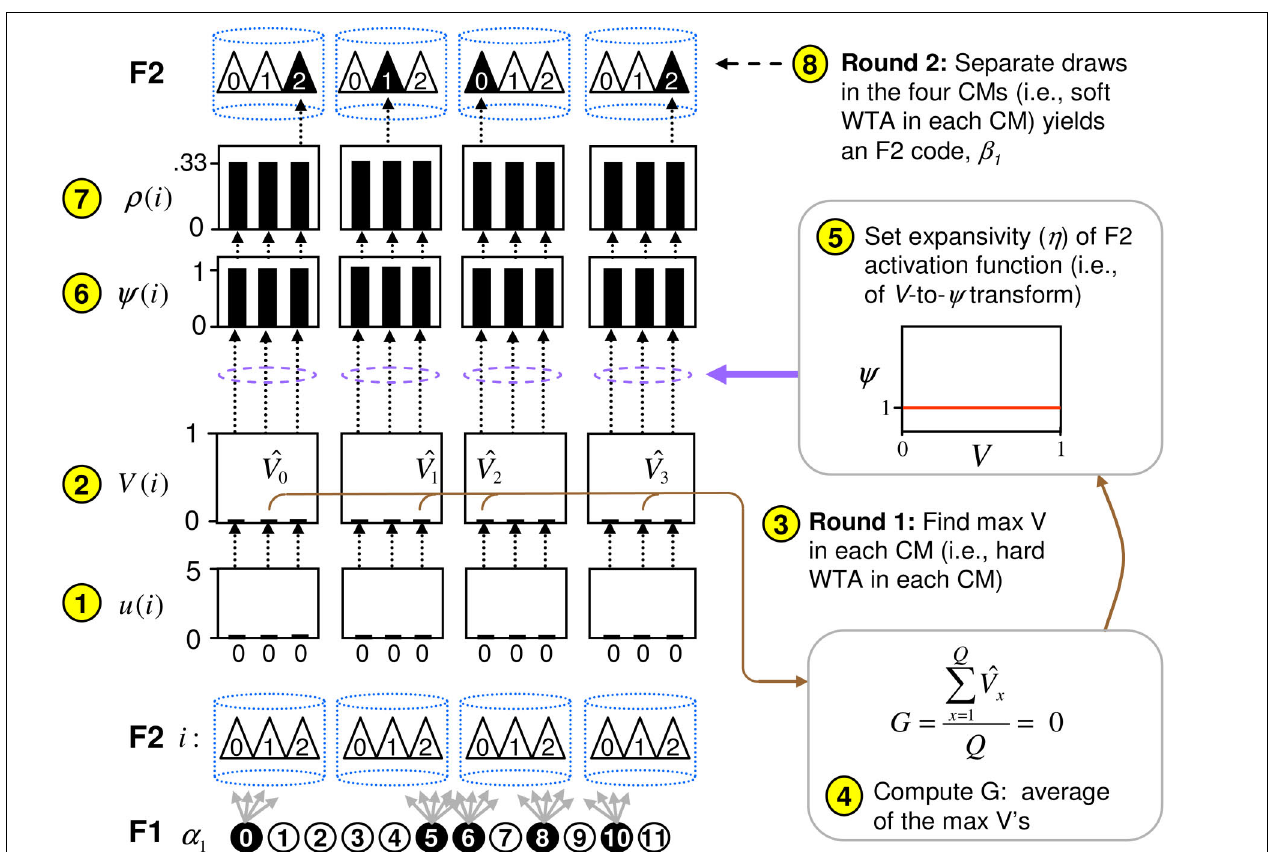
to be 0, and sets the F2 activation function to a constant function (red line), FIGURE 3 | Graphic illustration of the CSA. Circled numbers refer to algorithm which makes the choice of winner in each CM completely random, and thus, the steps in text. Here, I show the case of the fi rst input, α , presented to the 1 overall F2 code, β model. The algorithm detects that α is completely unfamiliar, i.e., G is computed , also completely 1 1